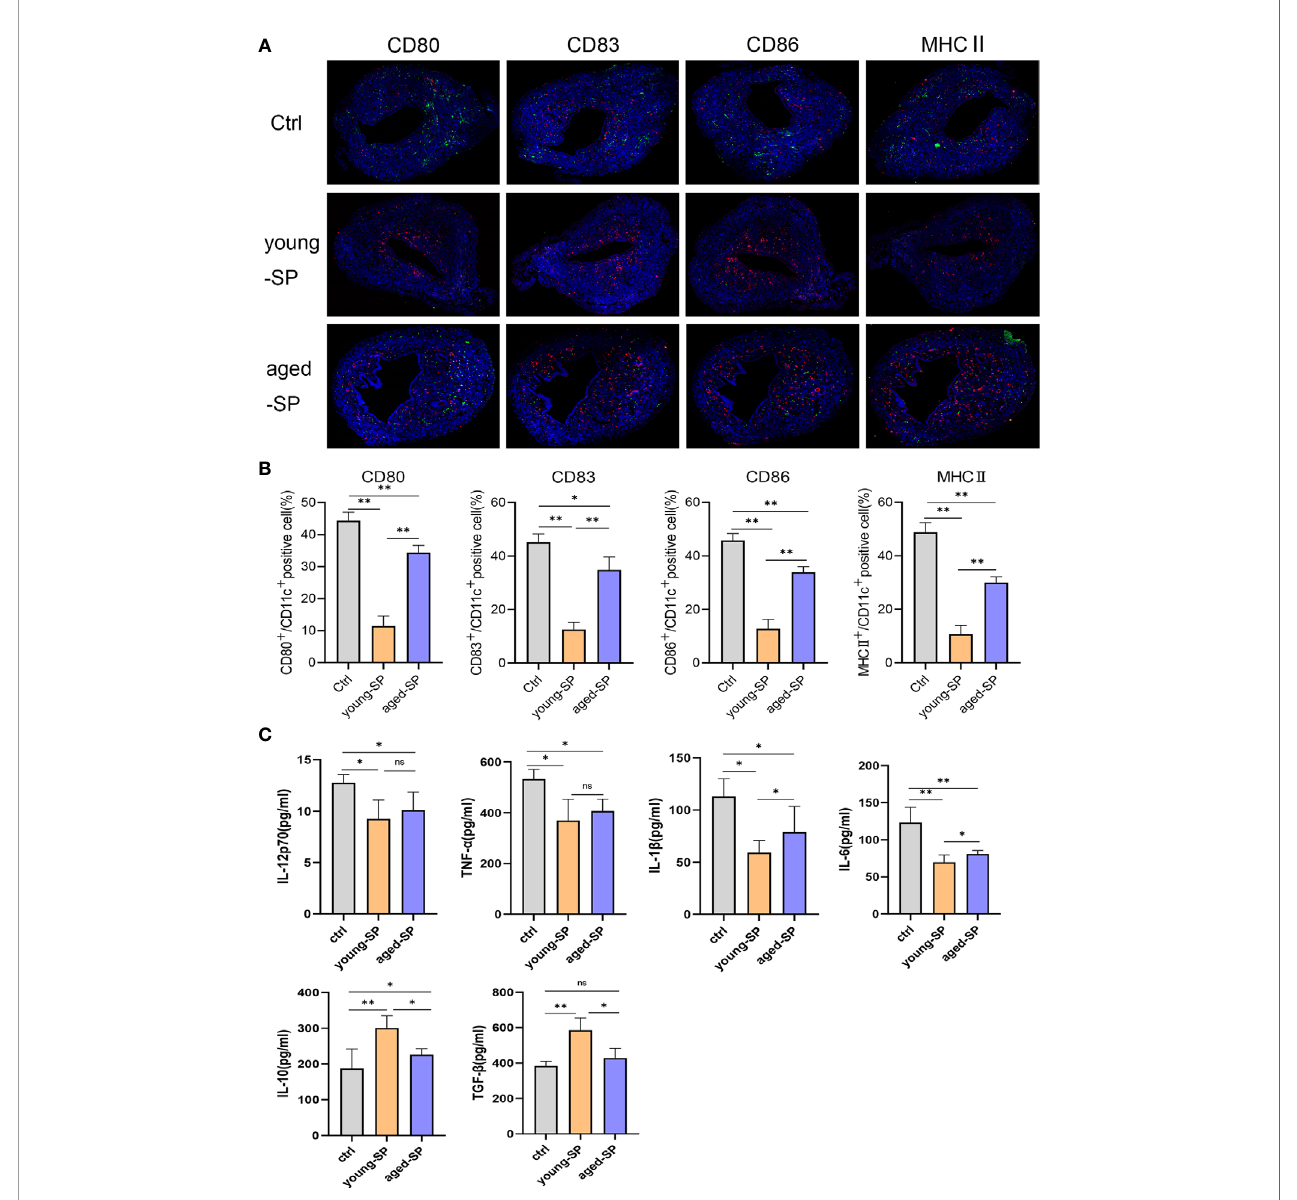
FIGURE 3 | Alterations of uterine DC maturation status between young-SP group and aged-SP group in vivo . (A) Representative sections of the uteri from control group, young-SP group, and aged-SP group mice, immunostained with anti-CD11c (red) and anti-CD80/CD83/CD86/MHCII (green) antibodies. (B) Histomorphometric quanti fi cation of DC densities in the myometrium and endometrium of control group, young-SP group, and aged-SP group mice. (C) ELISA analysis demonstrating the concentration of IL-12p70, TNF- a , IL-1 b , IL-10, TGF- b , and IL-6 in uterine luminal fl uid (mean ± SD, n = 6).The differences among different groups were assessed by one-way ANOVA with Holm – Sidak post-hoc test. *p < 0.05 and **p < 0.01. DC, dendritic cell; SP, seminal plasma; ns, not signi fi